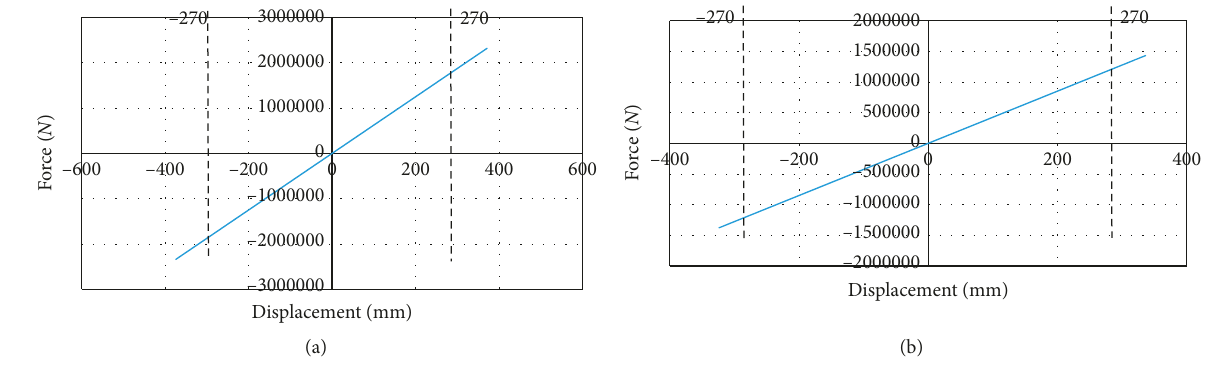
Figure 31: Force-displacement curves for the spring at pier 2. Table 5: Displacement criteria of spring elements.